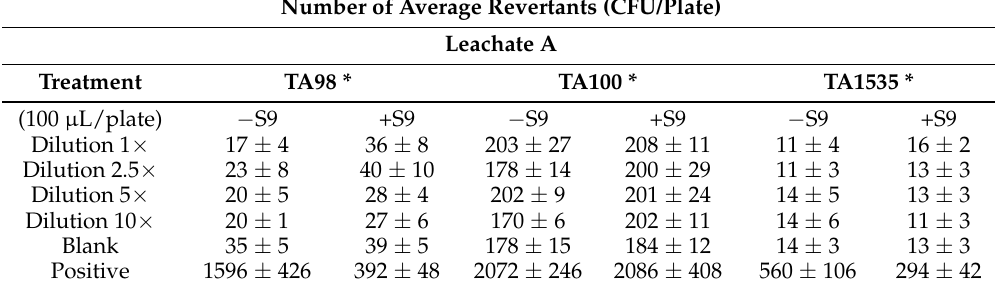
Table 8. Revertant frequency of Salmonella tester strains TA98, TA100, and TA1535 following incubation with leachate A from BA in presence and absence of S9 mix (mean ± SD is shown).